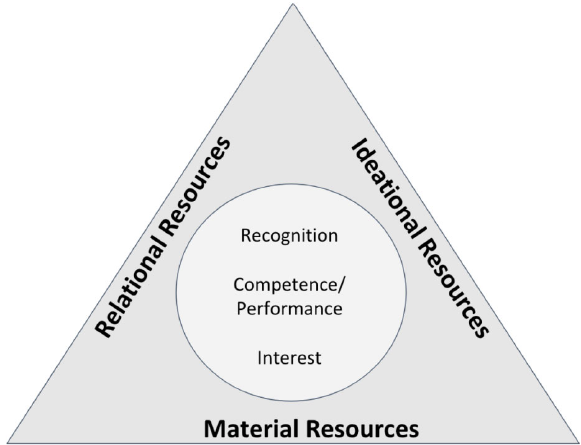
FIG. 1. An updated working model for the critical